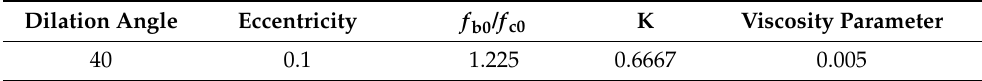
Table 1. Plastic damage parameters of the triaxial constitutive model of RAC. Dilation Angle